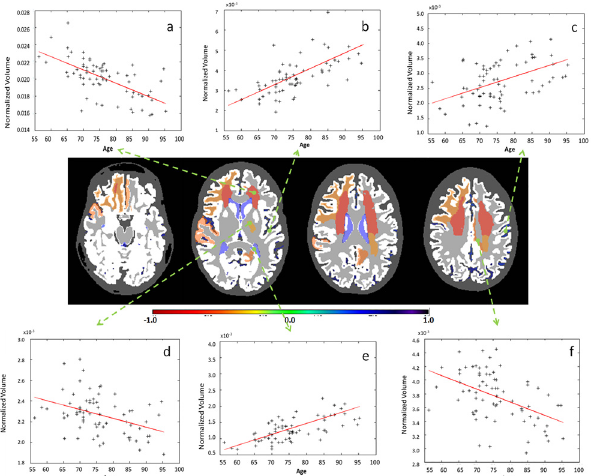
Fig 8. Examples of significant correlations between regional volumes and age at granularity level 4. The colors code the correlation coefficient R in regions where the age vs. volume curve achieves significance (p-value < 0.05, Bonferroni-corrected). Yellow / orange / red (R < 0) are regions that shrink over time, while blue (R > 0) are regions that expand over time, such as ventricles. As is shown in the figure: a. anterior part of the deep and periventricular white matter (left); b. Sylvian fissure and posterior insular sulcus (left); c. central sulcus (left); d. posterior limb of the internal capsule (left); e. Inferior part of the lateral ventricle (left); f. subcortical white matter of the cingulate gyrus (left).